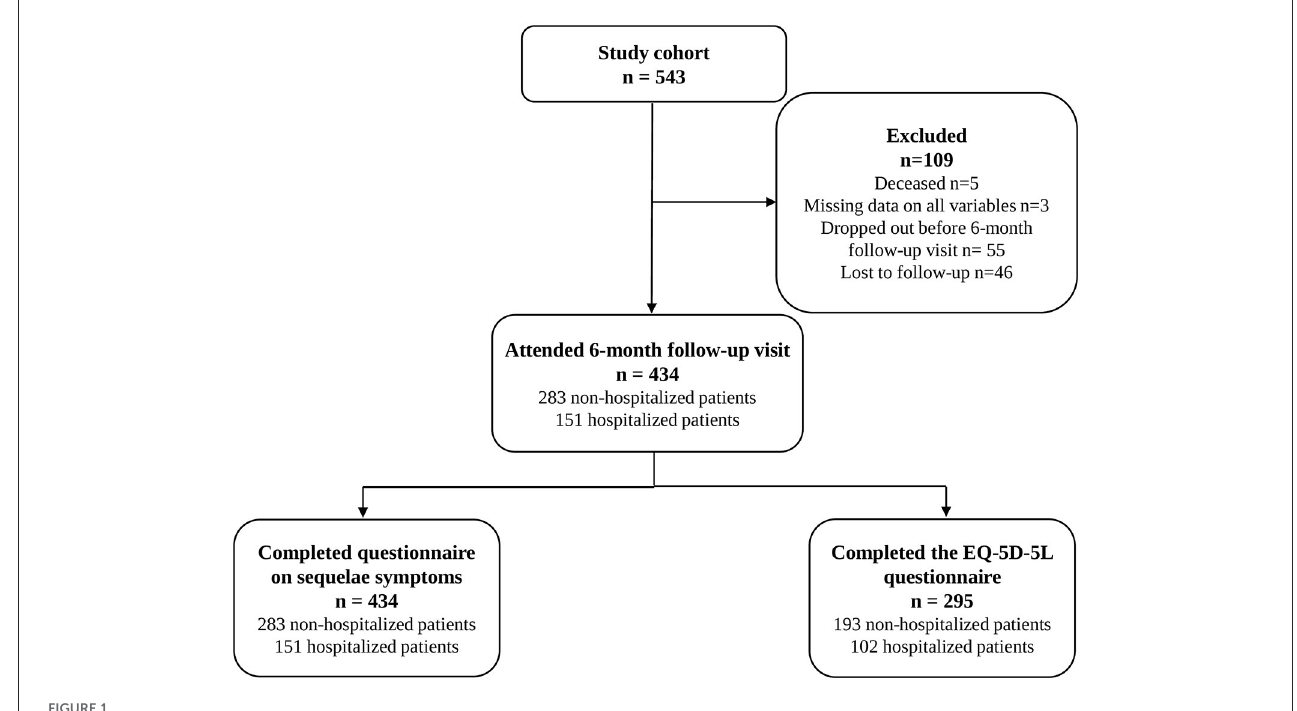
FIGURE1 Flowchart of included